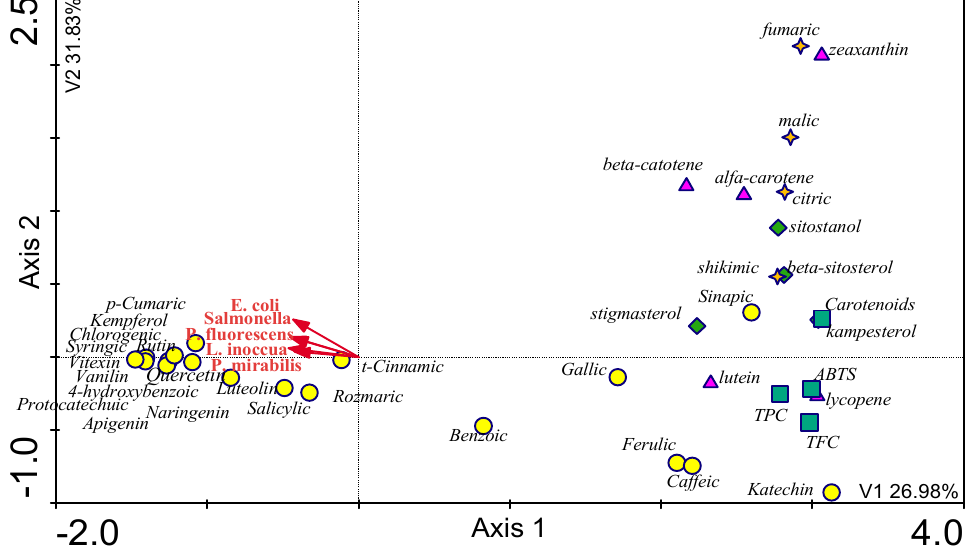
Figure 6. Canonical correlation analysis (CCA) ( n = 38). Dependencies between groups of phenolic acids, organic acids, pigments, sugars, and their influence on the pathogenic and food spoilage microorganism’s development.